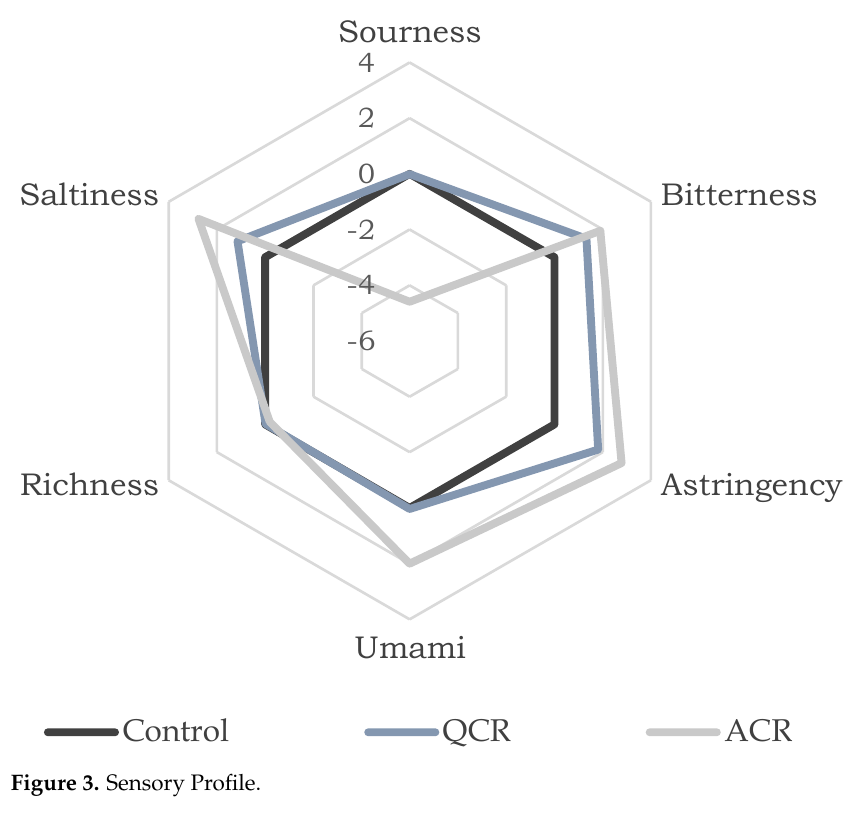
Figure 3. Sensory Profile.